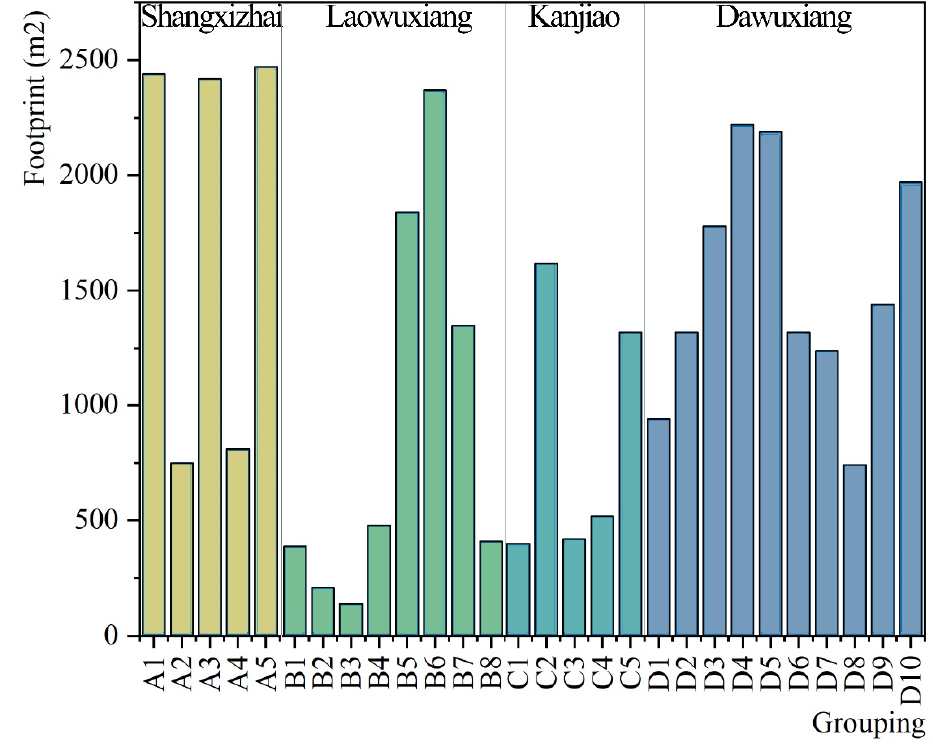
Figure 12. Breakdown of the area statistics of the V2 fire-protection zones in High chair Village.